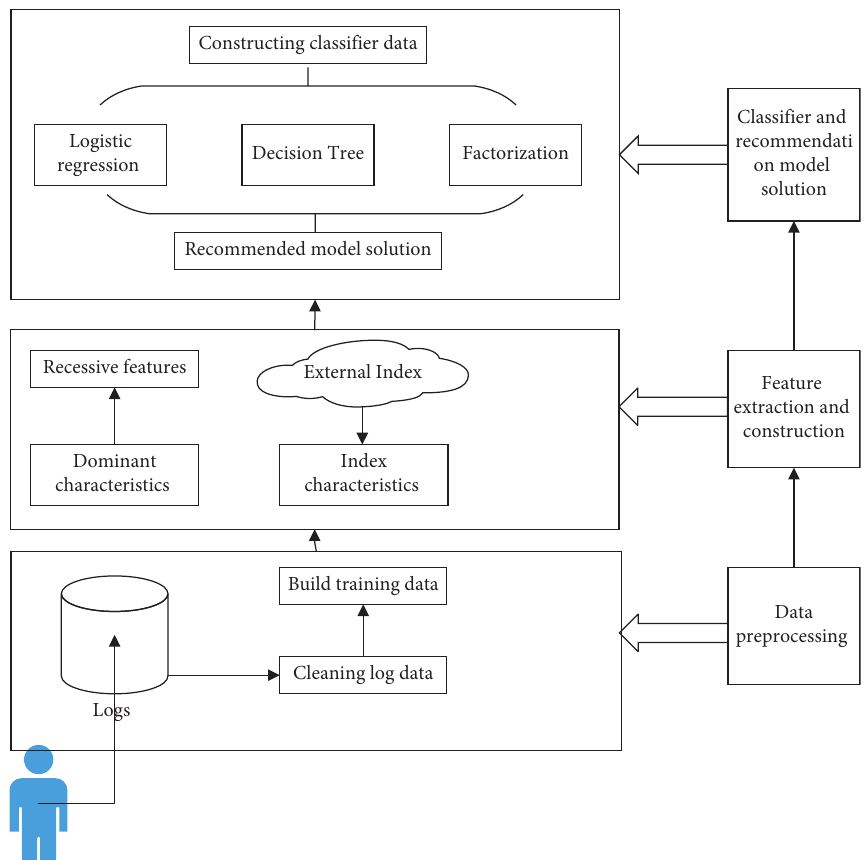
Figure 3: Short video recommendation flow